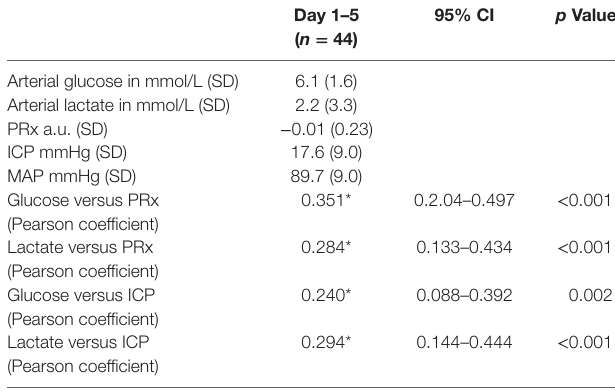
TaBle 1 | Demographics of pediatric patients presenting with a traumatic brain injury.